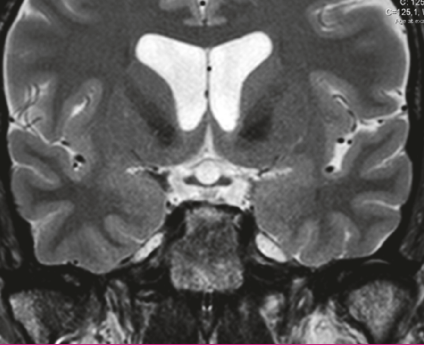
Figure 4: MRI of sella turcica at 10-month follow-up (May 2015): normal pituitary size with discrete heterogenous